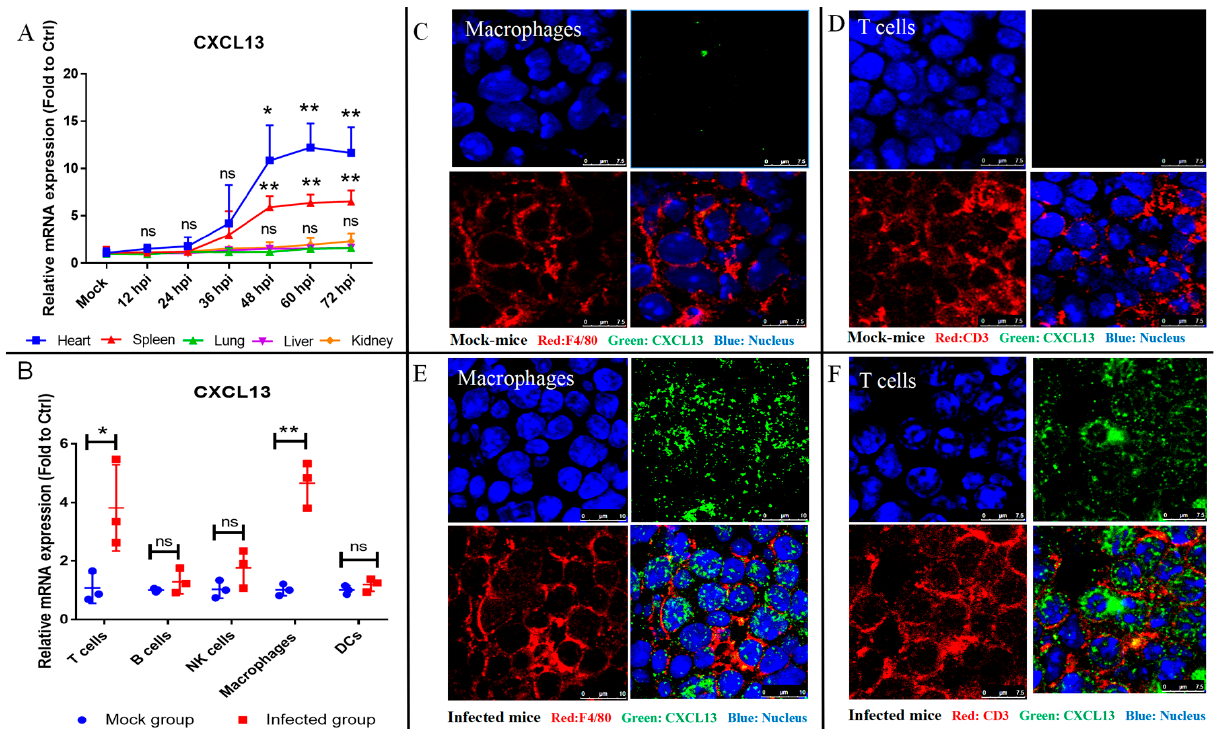
Figure 1. Macrophages and T cells were the cellular sources of CXCL13 in FMDV-infected mice. ( A ) The mRNA expression of CXCL13 in various tissues from mock mice and infected mice at 12, 24, 36, 48, 60, and 72 hpi. ( B ) The mRNA expression of CXCL13 in various cell subsets sorted from mock mice and infected mice. CXCL13, F4/80 ( C ) or CD3 ( D ), and nucleus were co-stained in the spleen from mock mice. CXCL13, F4/80 ( E ) or CD3 ( F ), and nucleus were co-stained in the spleen from infected mice. CXCL13, F4/80, CD3, and nucleus are shown in green, red, red and blue, respectively. At least 10 fields of immunofluorescence were observed. Significance was detected using unpaired t test. *, p ≤ 0.05; **, p ≤ 0.01. While ns indicates a non-statistically significant difference ( p > 0.05).